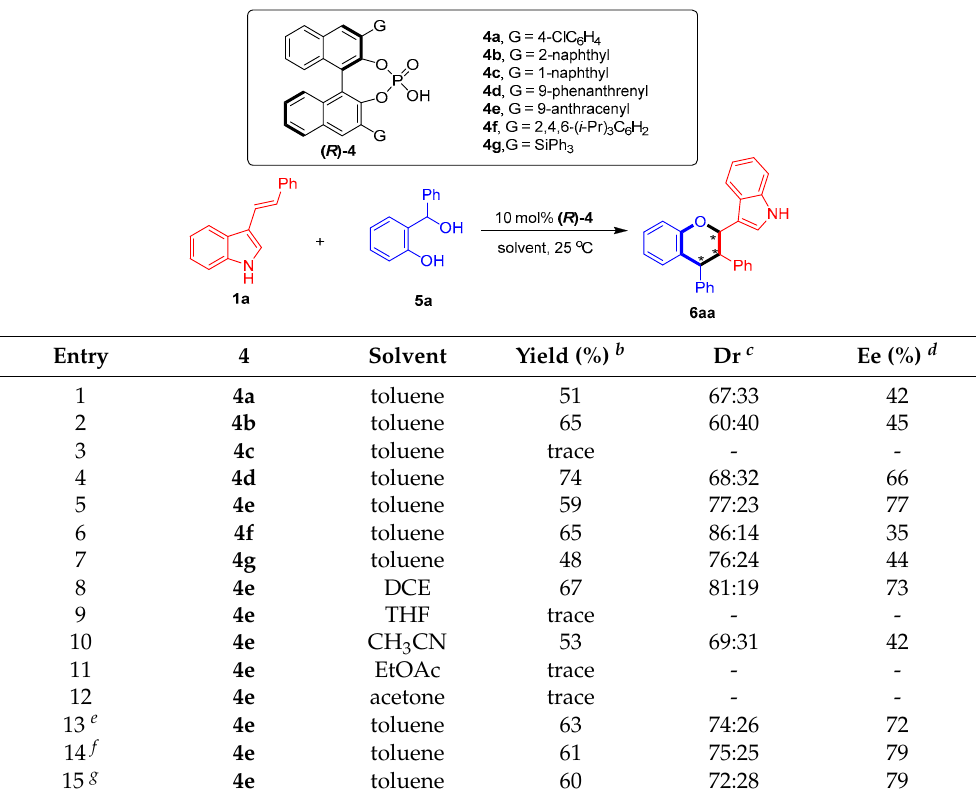
Molecules 2021 , 26 , x FOR PEER REVIEW